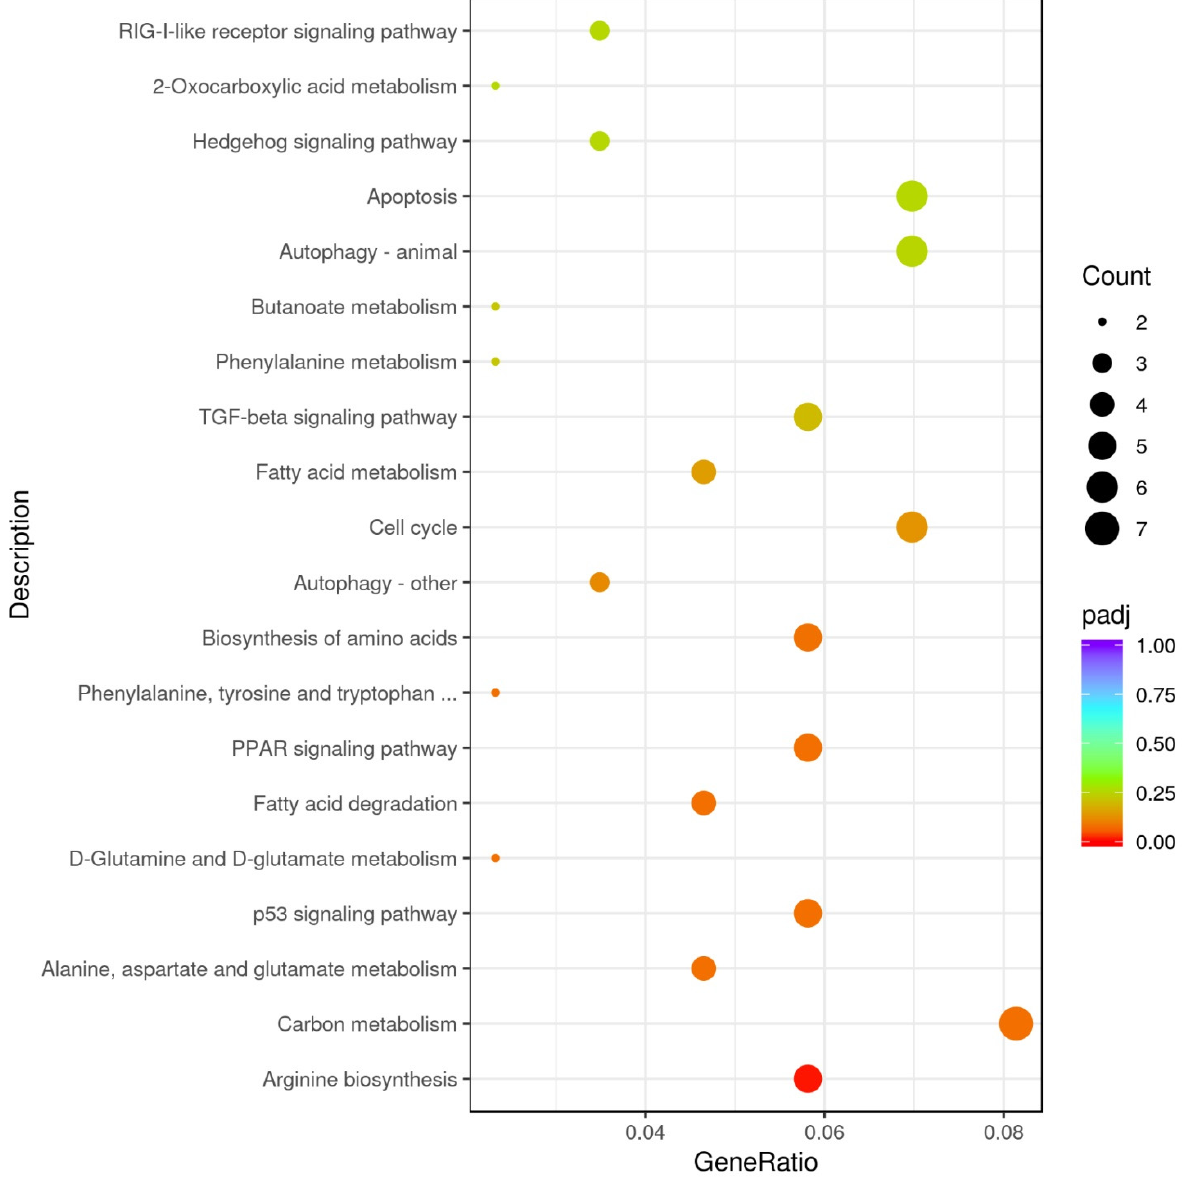
Figure 3. Scatter plot of the 20 most significant KEGG pathways. The size of the dots represents the number of genes annotated to the KEGG pathway, and the color from red to purple represents the significance of the enrichment.